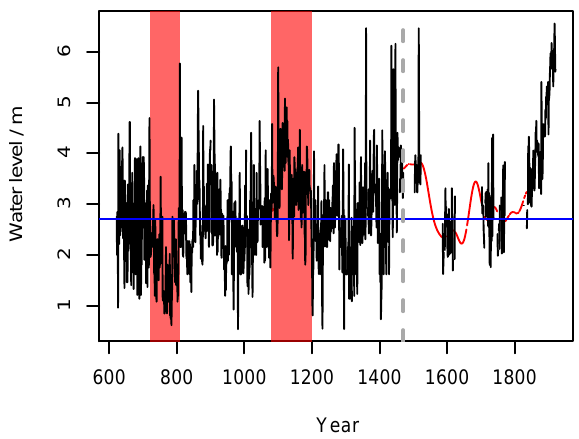
Fig. 1. Annual minima of Nile River water levels for the 1300 years between 622 A.D. (i.e., 1 A.H.) and 1921 A.D. (solid black line). The large gaps in the time series that occur after 1479 A.D. have been filled using SSA (cf. Sect. 2.2.1) (smooth red curve). The straight horizontal line (solid blue) shows the mean value for the 622–1479 A.D. interval, in which no large gaps occur; time intervals of large, persistent excursions from the mean are marked by red shading.